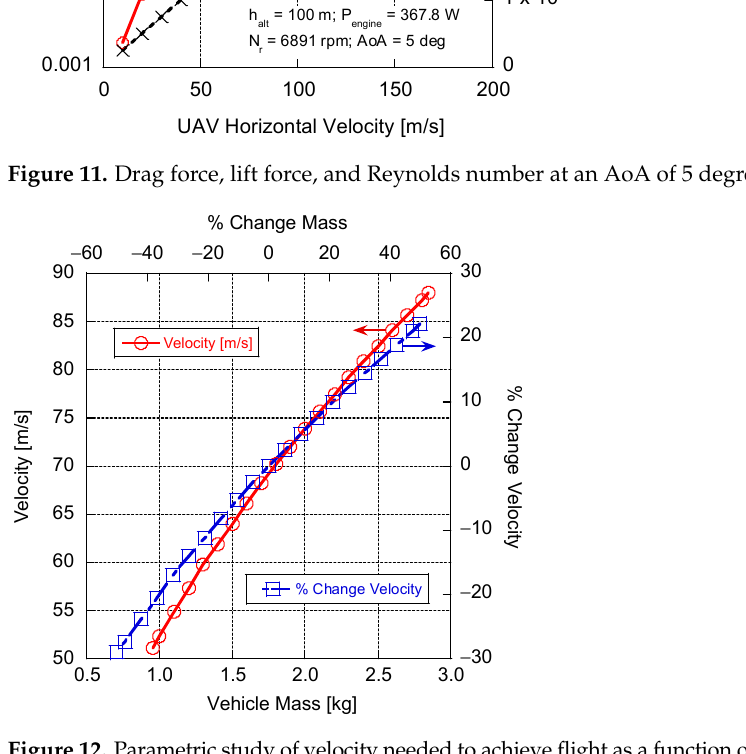
Figure 12. Parametric study of velocity needed to achieve flight as a function of the overall vehicle mass.